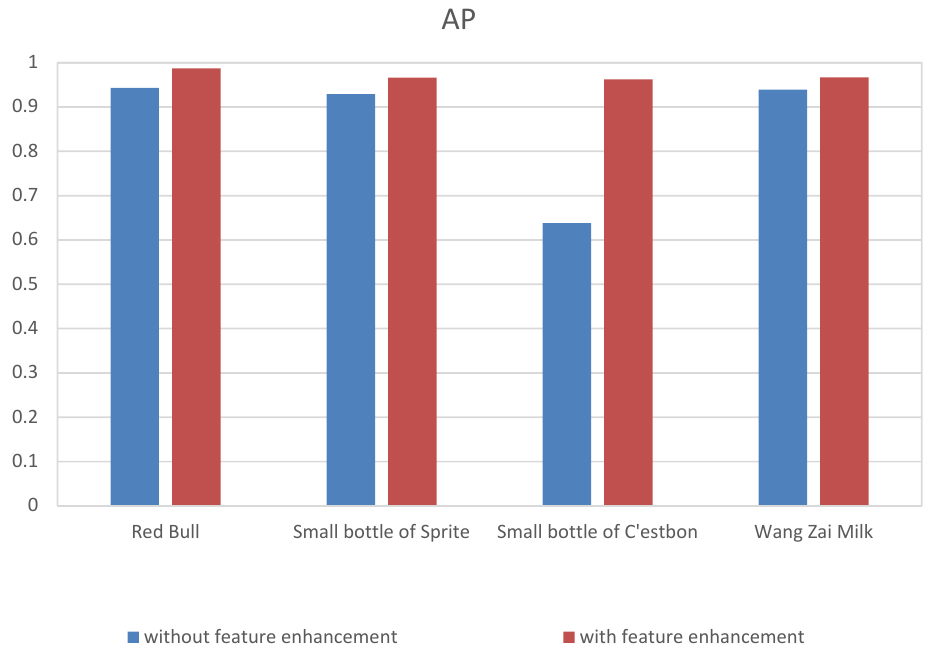
Figure 14. Ablation experiment of detection results with and without the feature enhancement.